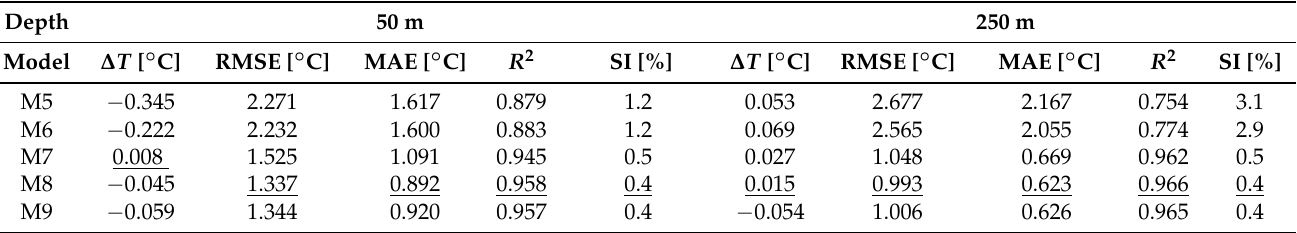
Table 3. The accuracy metrics calculated between the Argo-measured and model-predicted tempera- tures at depths of 50 m and 250 m for the five models listed in Table 2. The best performance metrics are highlighted by the underlined